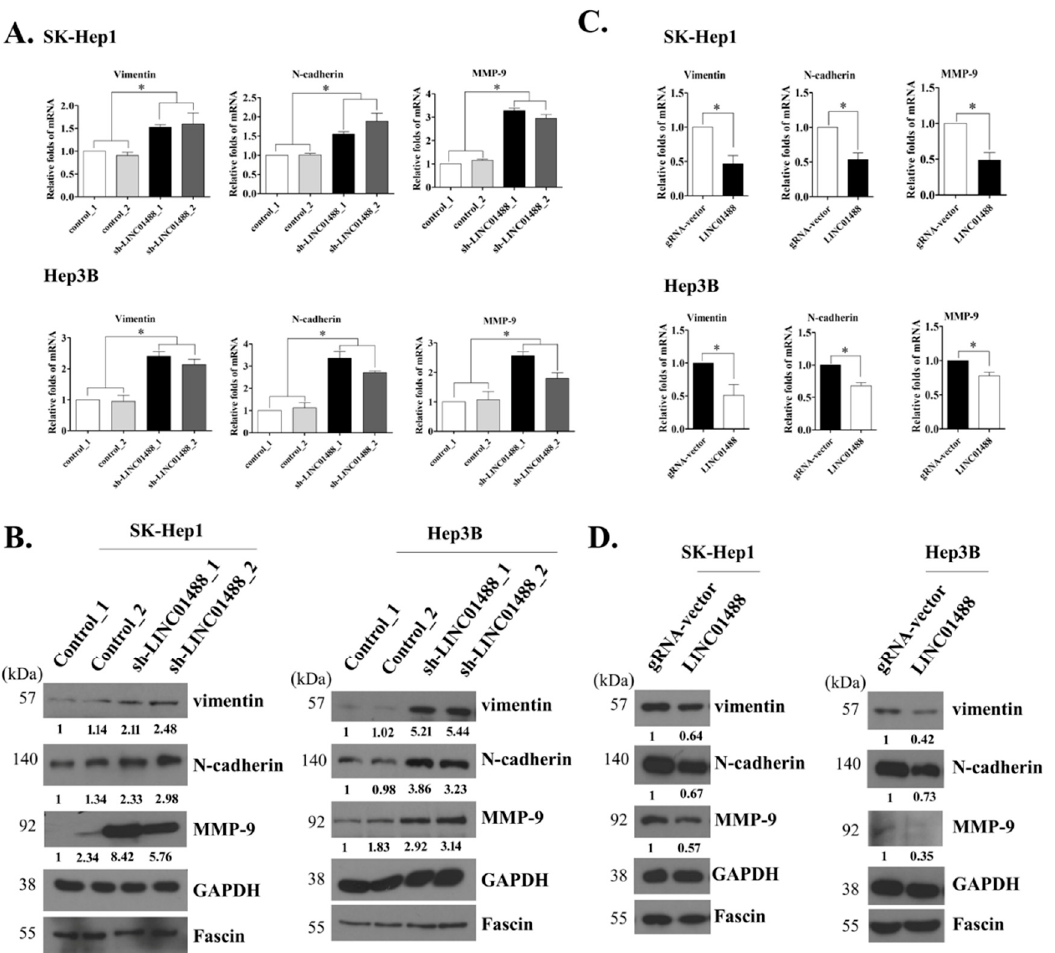
Figure 4. EMT markers negatively regulated by LINC01488. Depletion of LINC01488 a ff ected EMT expression levels in SK-Hep1 or Hep3B cells as determined via ( A ) q-RT-PCR or ( B ) Western blot analysis. Upregulation of LINC01488 suppressed EMT expression levels in SK-Hep1 or Hep3B cells as determined via ( C ) q-RT-PCR or ( D ) Western blot analysis. GAPDH and fascin were used as the loading controls. Data are presented as means ± SD (* p < 0.05; ** p < 0.01).